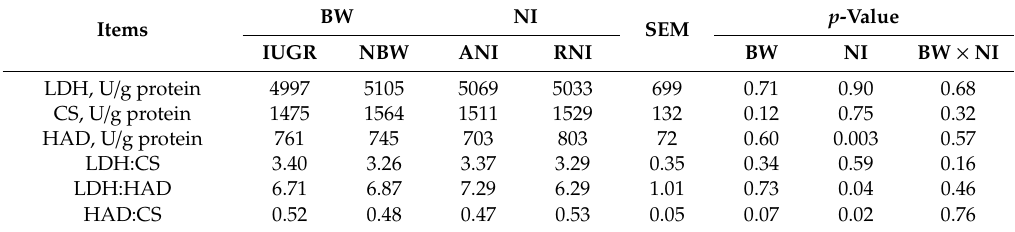
Table 7. E ff ects of the level of nutrient intake on metabolic enzyme activities in psoas major muscles of intrauterine growth-retarded (IUGR) and normal-birth weight (NBW) piglets.